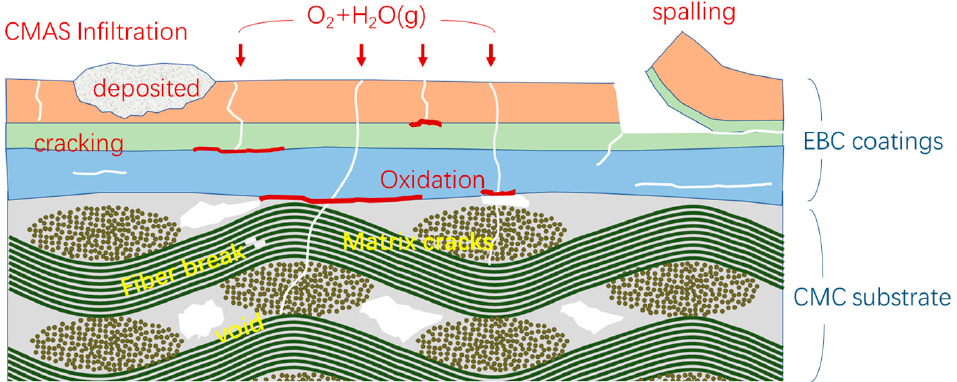
Figure 5. The typical failure mechanism of a CMC/EBC system.